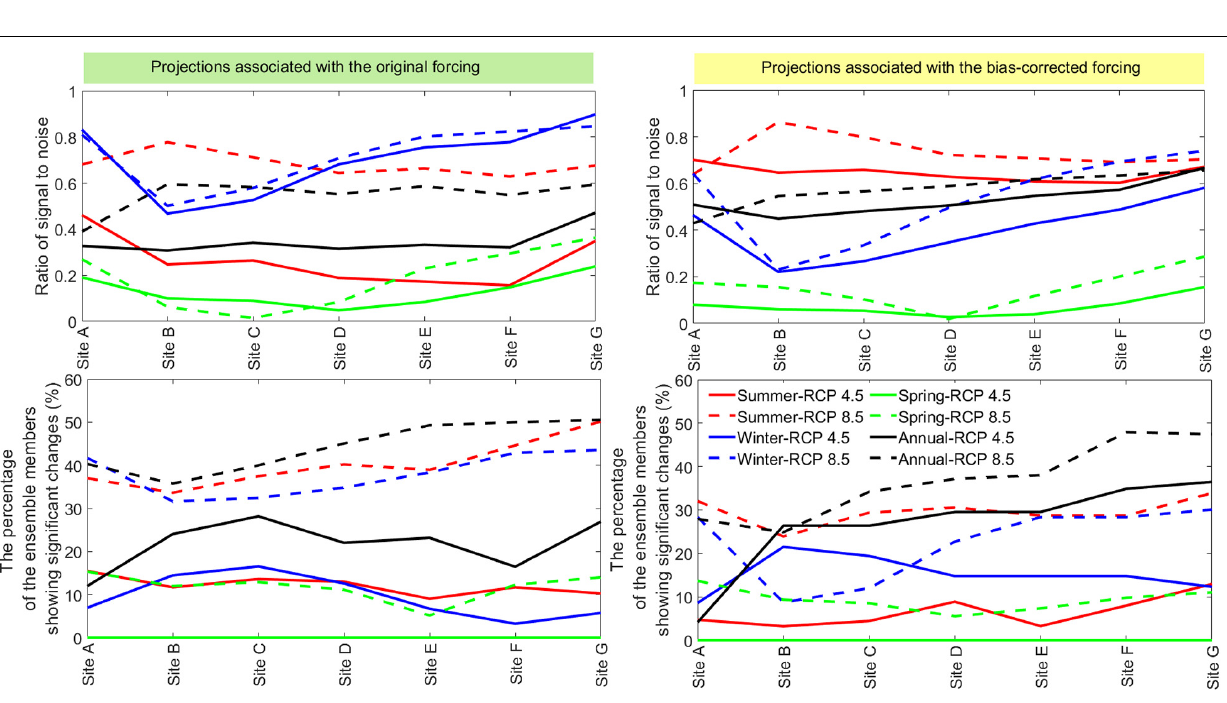
FIGURE 13 | Robustness of the projected changes in LST rates along the coast on annual and seasonal scales associated with using original forcing conditions (left panel) , and bias corrected forcing conditions (right panel) ; upper panel shows the ratio of signal to noise (first method for checking the robustness) and lower panel shows the percentage of the ensemble members showing significant changes (the second method for checking the